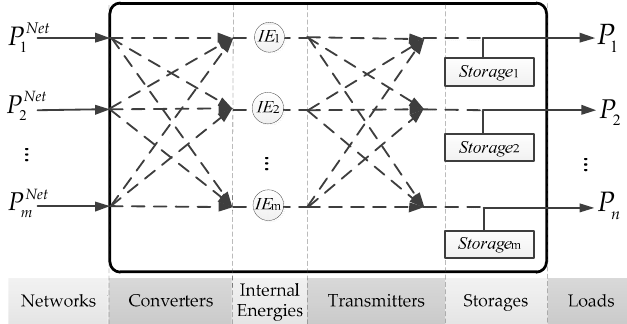
Figure 2. Energy hub model.